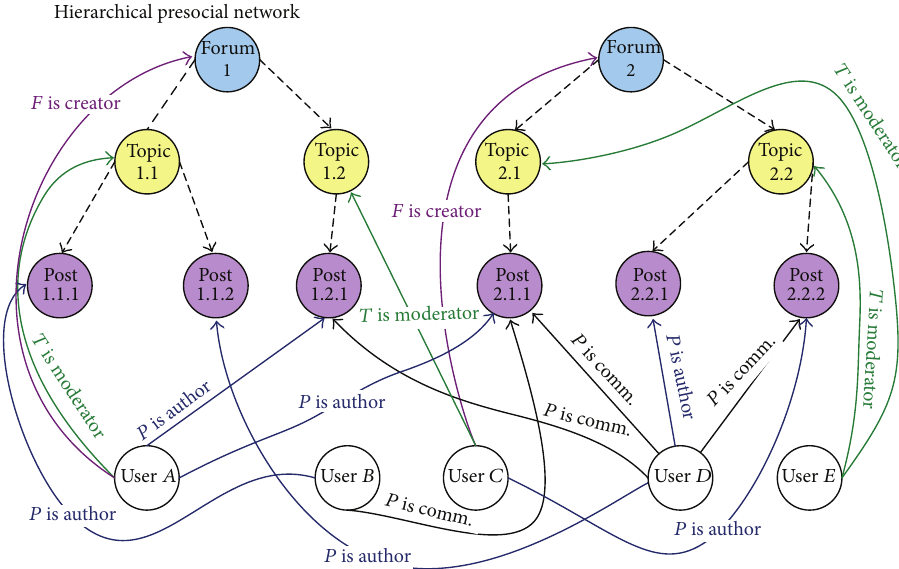
Figure 11: Relations between users and objects together with users’ roles towards the objects.